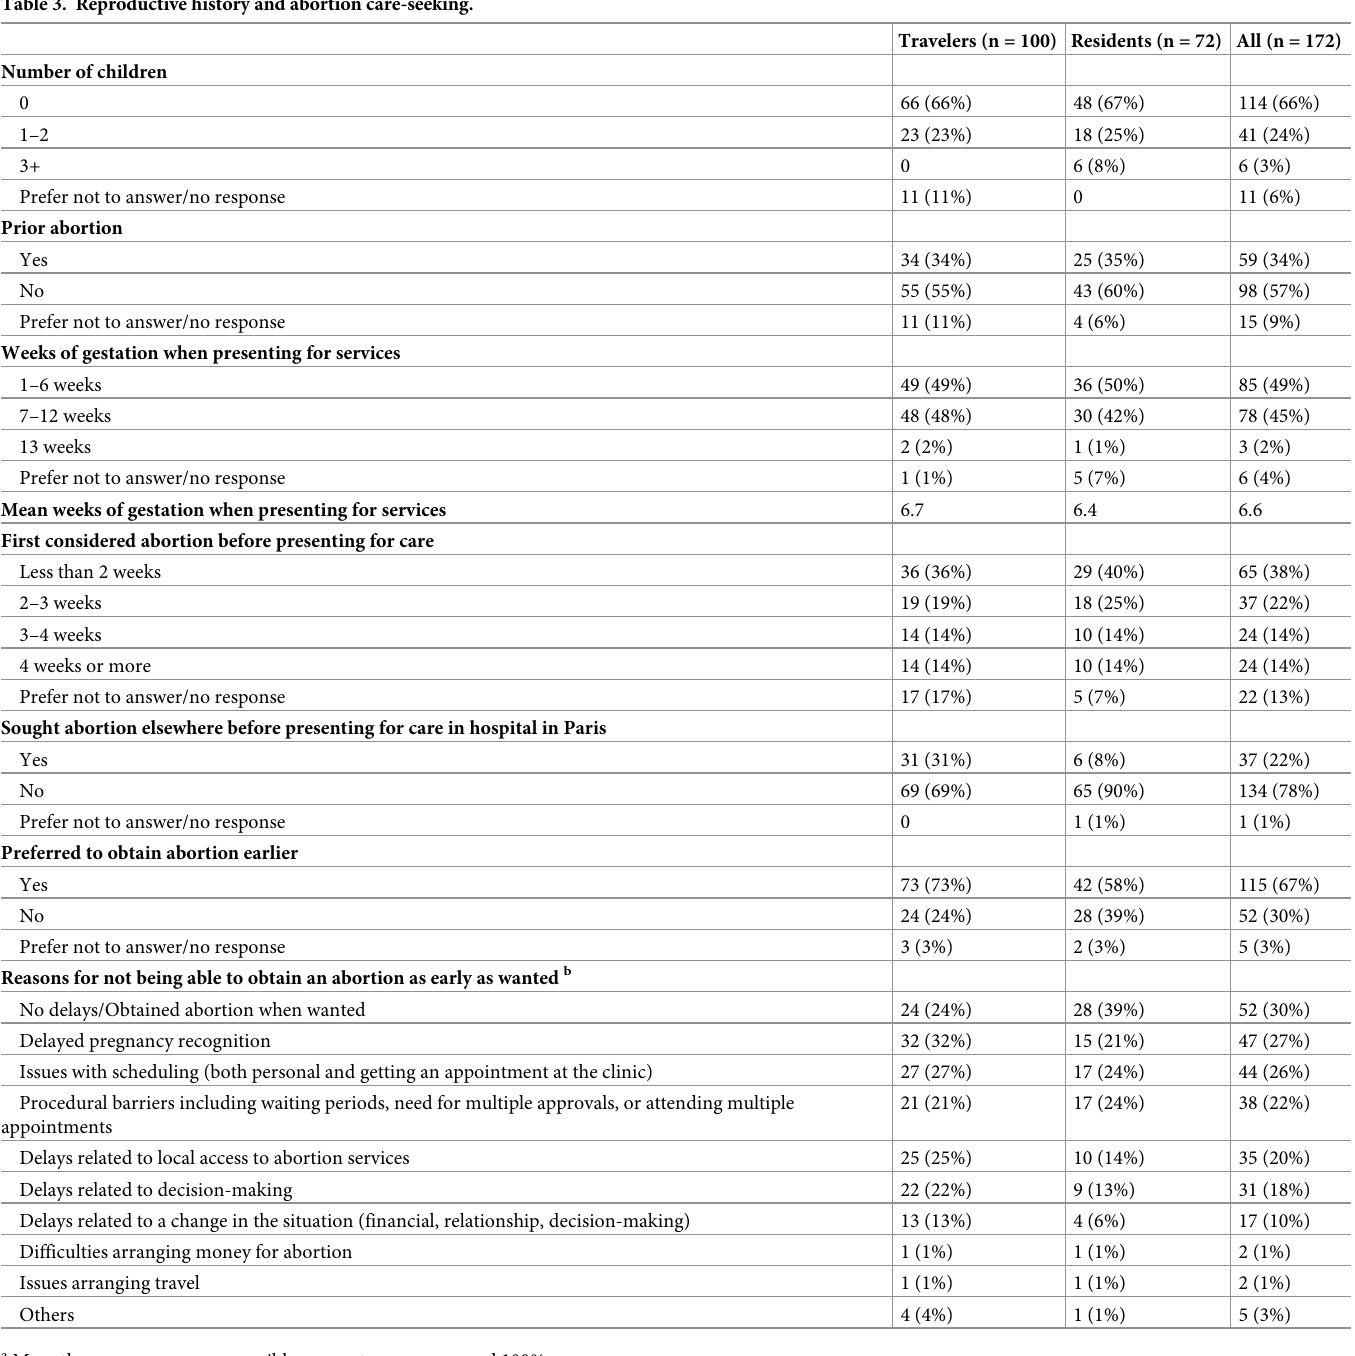
Table 3. Reproductive history and abortion